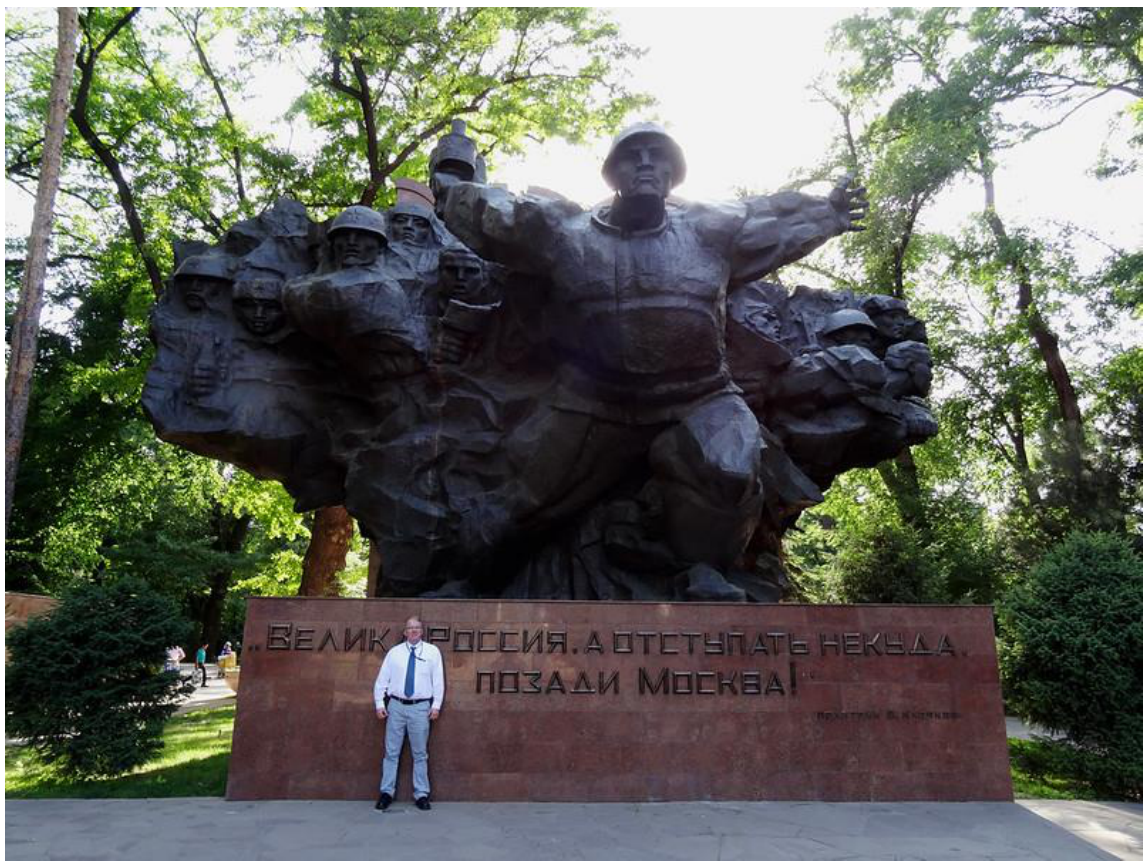
Figure 1. The author at the World War II Monument in the Park of 28 Panfilov Guardsmen in Almaty, Kazakhstan in June 2015. During his visit to Almaty, the author gave talks at Almaty Management University. Photo: Jeffrey